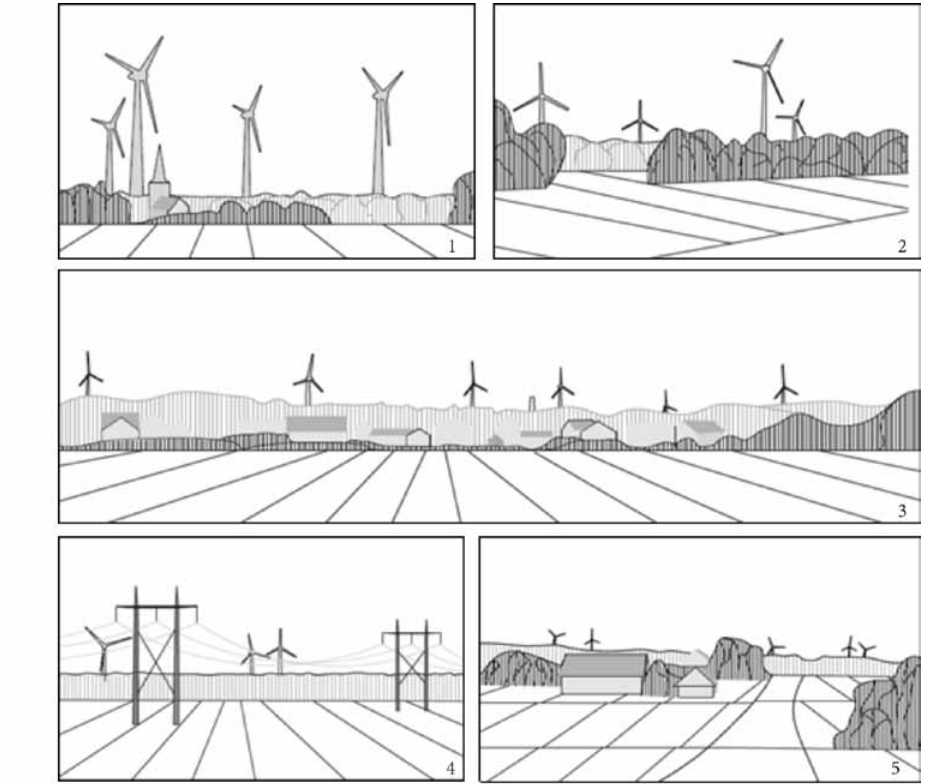
Fig. 1. Diagrams of the significance of the impact of the wind turbines in terms of degrees: 1 – visually dominating, 2 – generally dominating, 3 – accents, 4 –